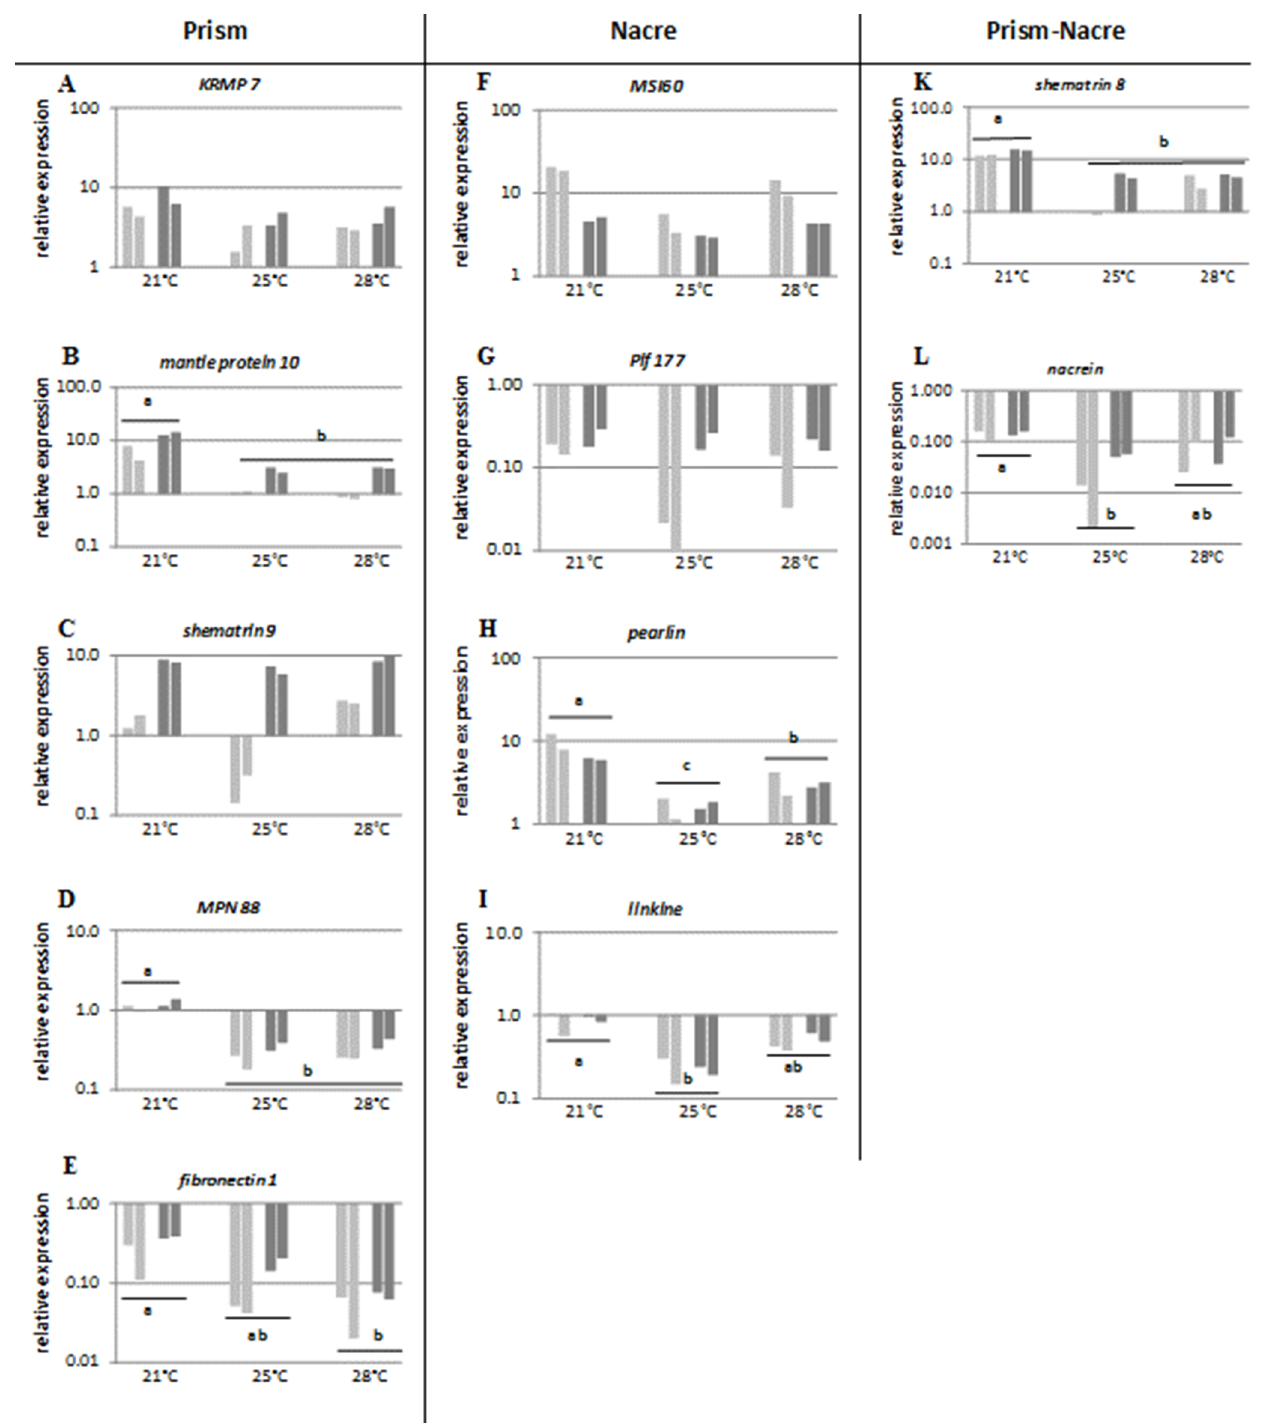
Figure 3. Relative gene expression of genes coding for proteins potentially involved in the construction of the prismatic layer ( KRMP7,mantleprotein10,shematrin9,MPN88,fibronectin1) the nacreous layer ( MSI60,Pif177,pearlin,linkine) and both the prismatic and the nacreous layers ( shematrin8,nacrein) following 2 months of exposure to 3 temperatures (21 u C, 25 u C and 28 u C) and 2 microalgal concentrations 800 cell mL 2 1 for low food (LF) (light grey) and 15 000 cell mL 2 1 for high food (HF) (dark grey). The results of two measures performed on a pool of 5 pearl oysters are shown for each condition. Statistical differences between temperatures are indicated by a letter. doi:10.1371/journal.pone.0103944.g003 evaluate P. margaritifera shell growth and the expression level of depending on environmental conditions (microalgal concentration genes encoding proteins of the shell matrix in the mantle and temperature). We showed that both food level and temper-